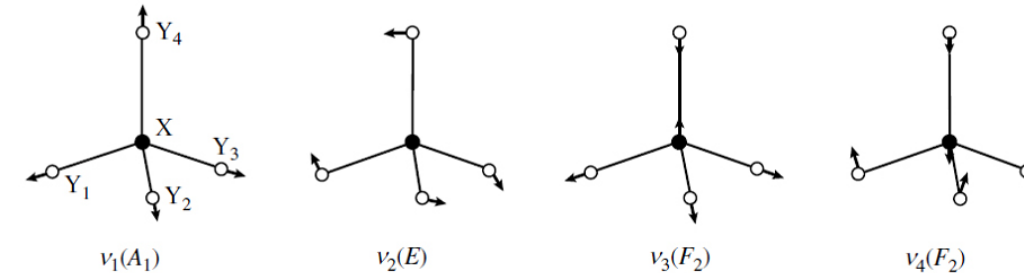
Figure 1. Schema of atomistic vibrations in XY